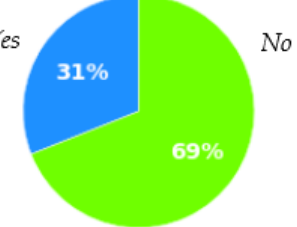
Figure 5. Answers for question of do you have any experiences on holdings of cryptocurrencies? While 100% of the respondents already knew that Bitcoin is the first-ranking cryp- tocurrency in the world (Table A7), only 38% of the respondents knew that the Ethereum is the second-ranking cryptocurrency in the world (Table A8).